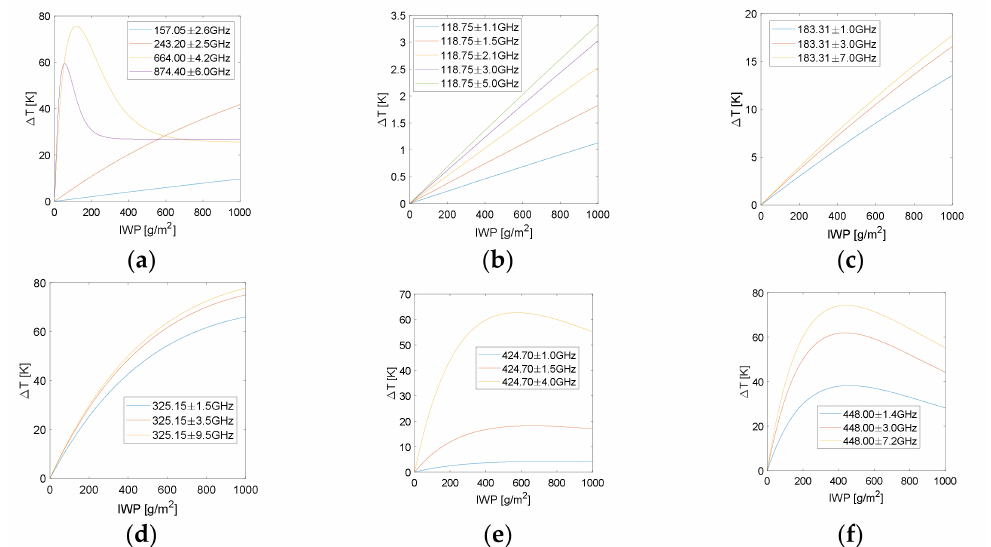
Figure 4. Brightness temperature di ff erence caused by di ff erent ice water paths. ( a ) Window. ( b ) 118.75 GHz (O2). ( c ) 183.31 GHz (H2O). ( d ) 325.15 GHz (H2O). ( e ) 424.70 GHz (O2). ( f ) 448.00 GHz